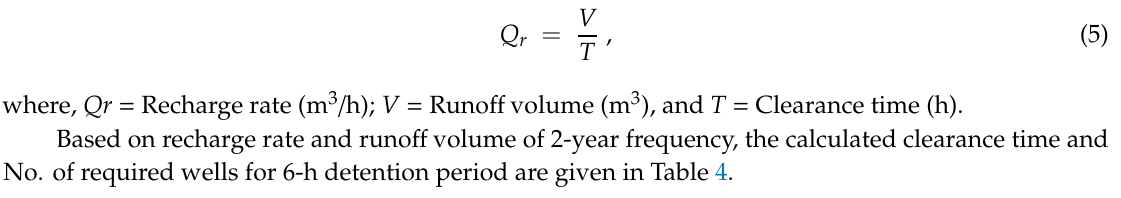
Table 4. Calculation of ponding area clearance time and required No. of wells at Gaddafi Stadium